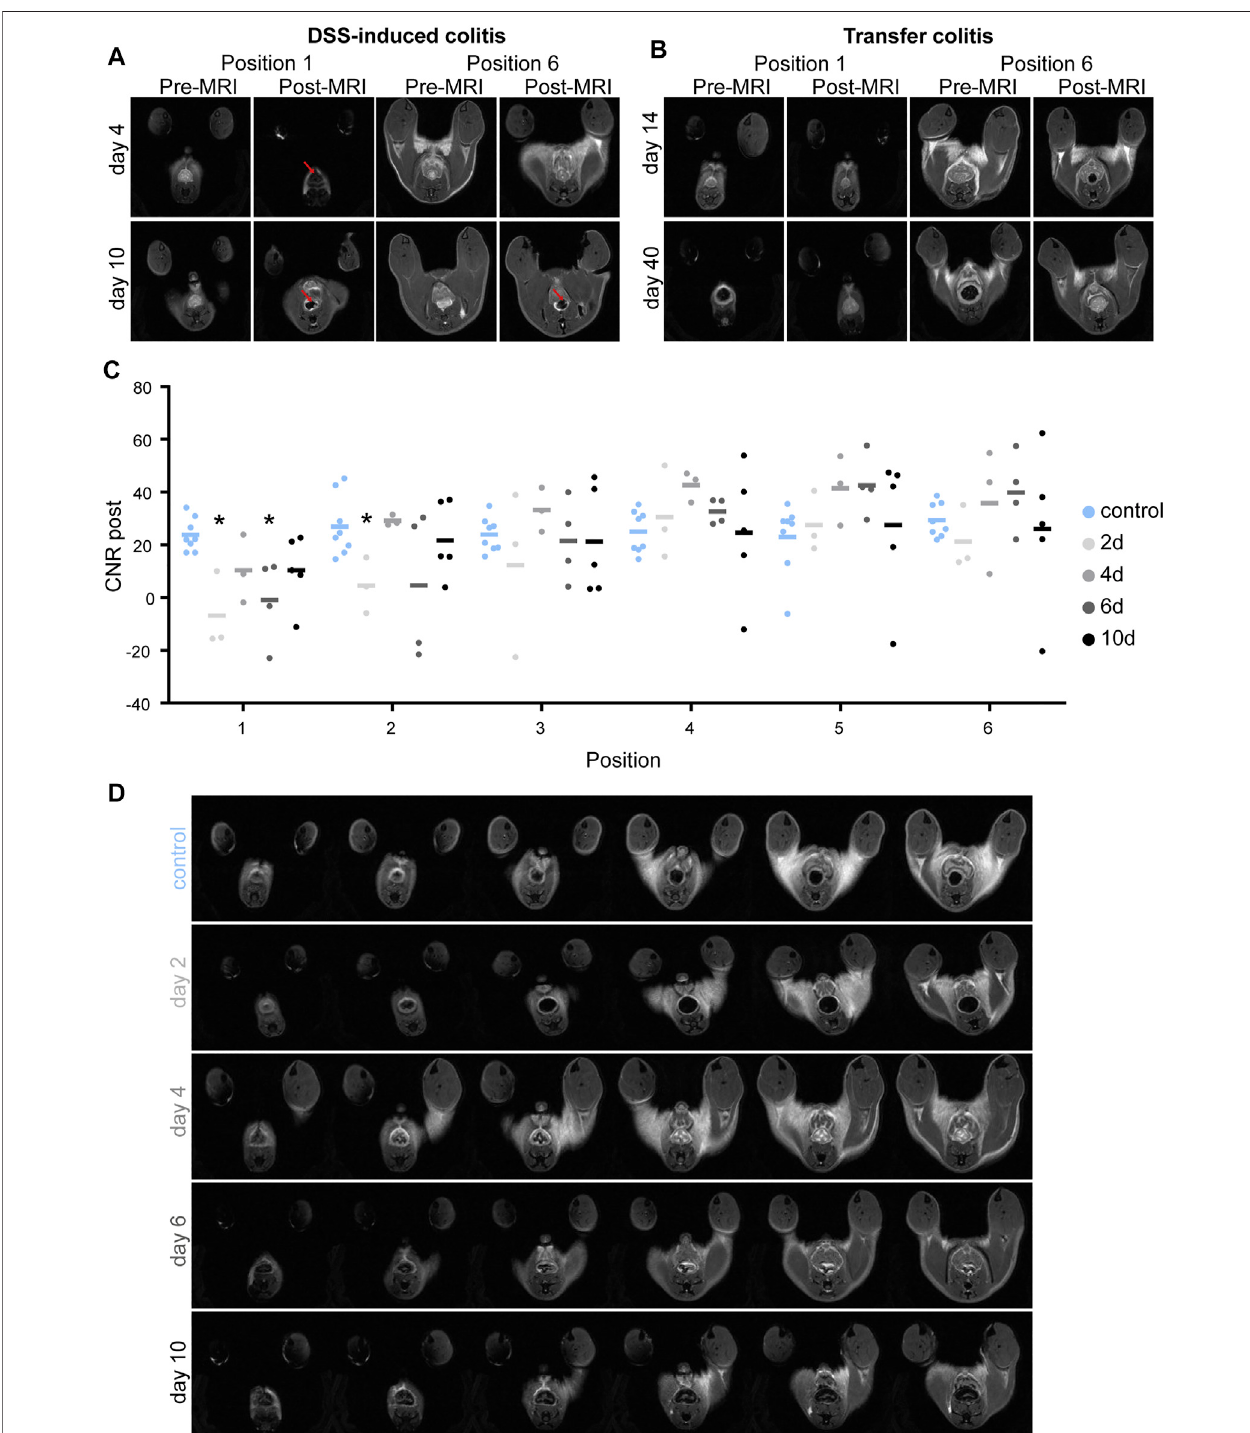
FIGURE 1 | Accumulation of VSOP-induced signal loss in the colon of DSS-induced colitis mice. (A) Representative pre- and post-colon MRI images of mice with DSS- inducedcolitisatdays4and10,respectively.Upperrowshowsimagesofpre-andpost-MRIscansofamousewithDSS-inducedcolitisonday4inposition1and6,respectively. Lowerrowindicatesimagesofpre-andpost-MRIscansofamousewithDSS-inducedcolitisonday10inposition1and6,respectively.Redarrowspointtoareasofsignalloss indicatingVSOPaccumulation. (B) RepresentativecolonMRIimagesofmicewithtransfercolitisatdays14and40.Upperrowpresentsimagesofpre-andpost-MRIscans ofamouseonday14aftertransfercolitisinductioninposition1and6,respectively.Lowerrowindicatesimagesofpre-andpost-MRIscansofatransfercolitismouseonday40in positiononeand6.Thereisnosignallossdiscernible. (C) Graphicsummaryofcontrasttonoiseratio(CNR)incolonwallofpositiononetosix,atdays2( n =3),4( n =3),6( n =4), and 10 ( n = 5). The CNR in colon wall of healthy control animals is represented in blue for every position ( n = 7). Statistical signi fi cance was tested with Mann-Whitney test (non- parametric t -test)with p ≤ 0.05de fi ningthestatisticalsigni fi cancethatismarkedwith p . (D) Representativesub-sequentialaxialpost-MRIimagesfromoneanimalofeachgroup.